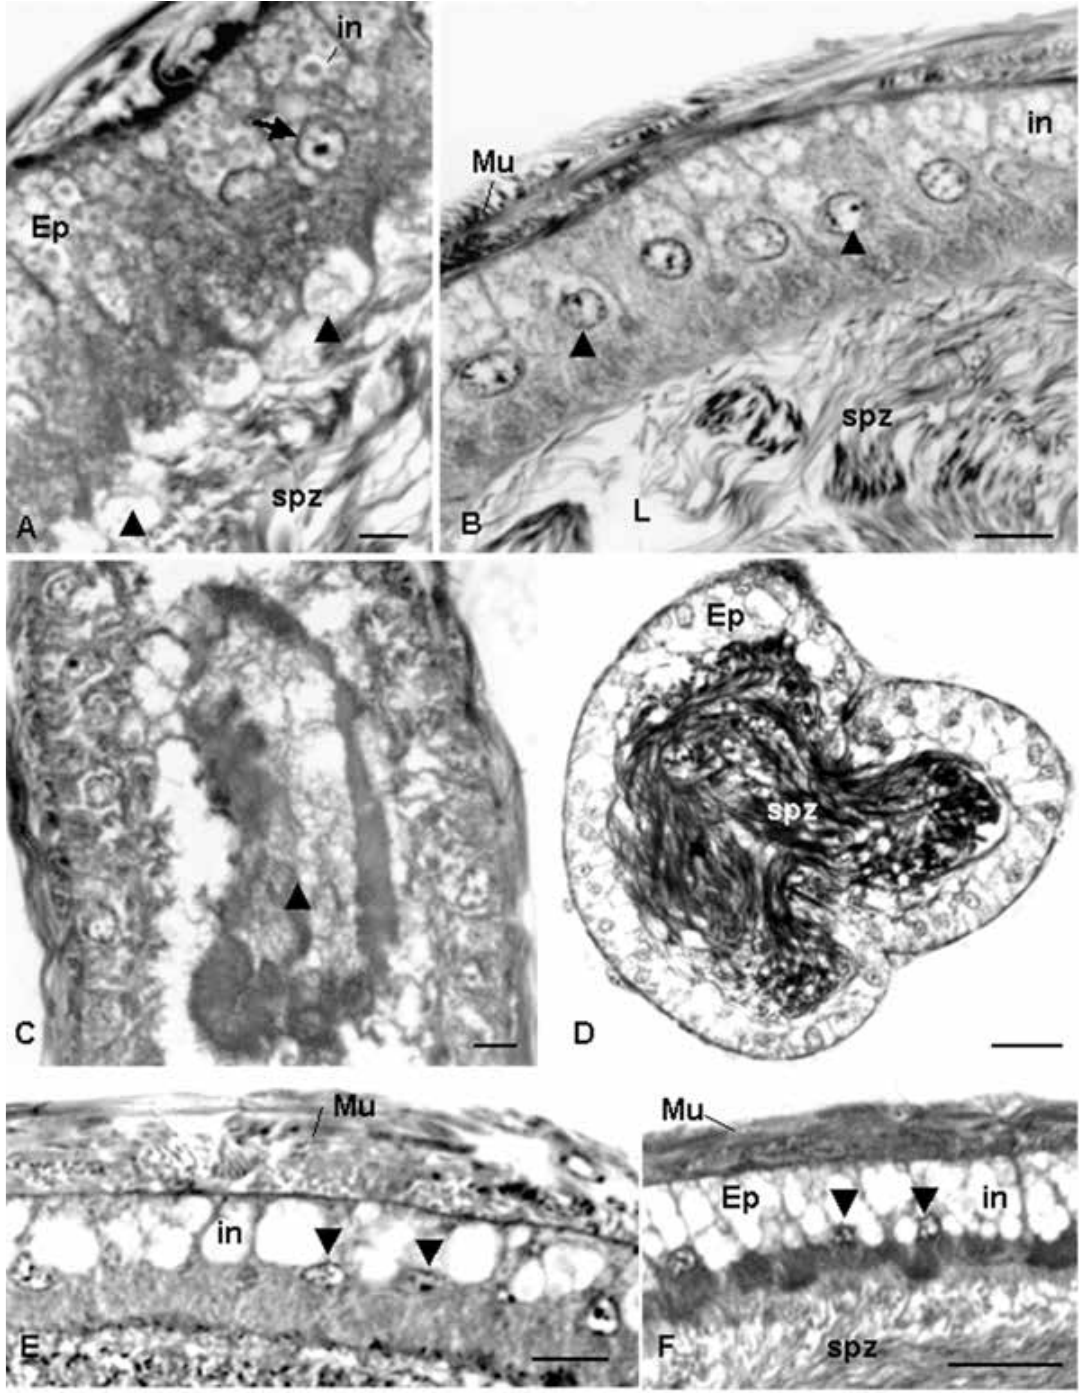
Fig 3. Light micrographs of transverse sections of the seminal vesicles and post-vesicular vasa deferentia of Scaptotrigona xanthotricha . A. Seminal vesicle of a 5-day-old adult showing lumen with spermatozoa (spz), and vesicles (arrowhead) at the apex and base (in) of the epithelial cells (Ep). Nucleus (arrow). B. Seminal vesicle with cubic epithelium showing sperm (spz) in the lumen (L), and cells with spherical nucleus (arrowhead) and vesicular inclusions in the basal region. C-D. Vasa deferentia with secretions (arrowhead) and sperm (spz) in the lumen. E-F. Seminal vesicle of 10-day-old males showing sperm (spz) in the lumen, and many vesicular inclusions (in) in epithelial cells (Ep). Nucleus (arrowheads). External muscle (Mu). Bars: A-B = 10µm; C = 15µm; D-F =